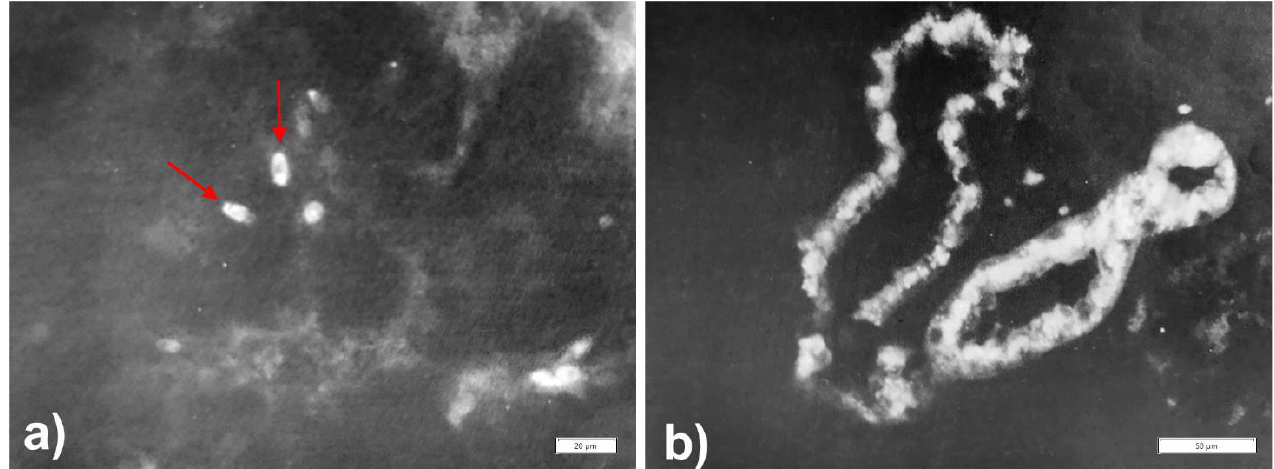
Figure 11. Immunofluorescence staining for AAT on an autopsy testis ( a ) and kidney ( b ) specimen from a Pi Z patient. A few spermatozoa are seen in the lumen of the epididymal duct. Heads of sperm cells shows AAT immunoreactive dots. The immunoreactive dots correspond to the acrosome (arrows) ( a × 516). Immunofluorescence staining for AAT on a kidney from the same patient. Two proximal tubules show a very strong granular–globular positivity for AAT ( b × 320). (Figures reprinted from Callea F. PhD thesis. Acco, Leuven 1983: 1.153).